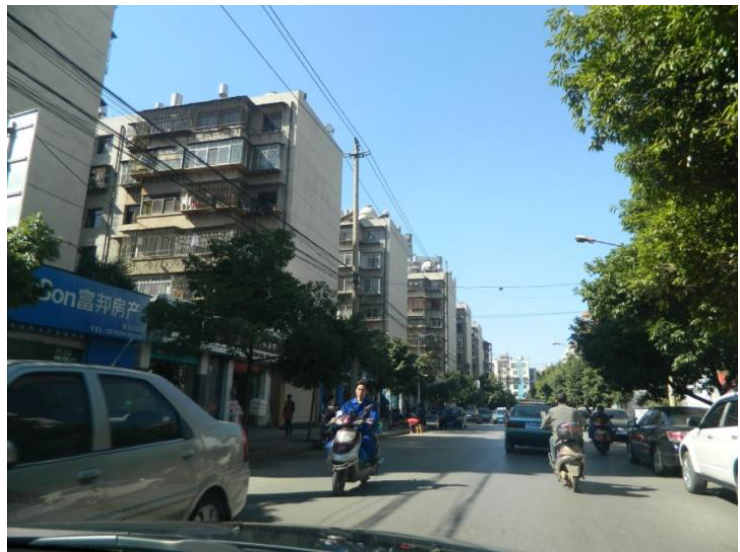
Figure 2. Typical narrow-depth residential